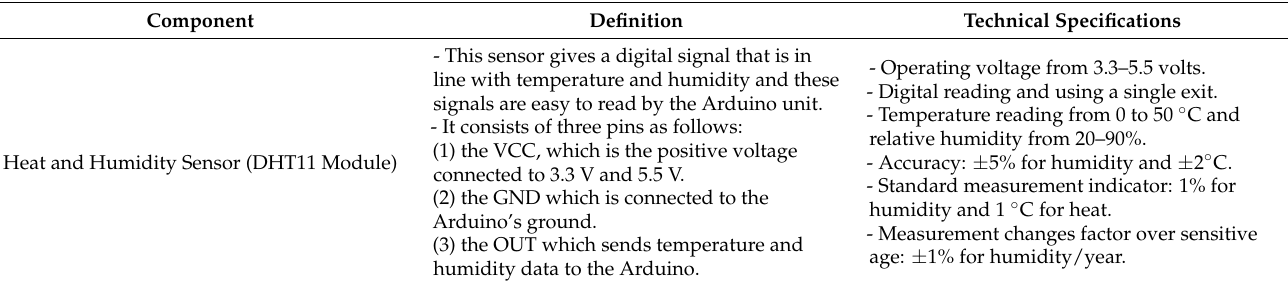
Figure 8. The graphical user interface used to display the temperature and humidity of the smart home on the phone. Table 4. The main components used to control the humidity and temperature system.